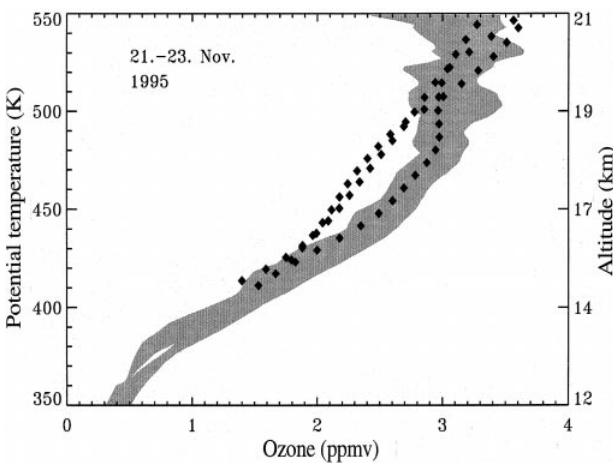
Fig. 15. The ozone profiles observed by HALOE in late November 1995 inside the vortex ( diamonds ) compared with ground-based lidar observations (at 80.0 (cid:14) N, 86.4 (cid:14) W) inside the vortex ( Donovan et al ., 1996) between November 29, and December 29, 1995. The grey area indicates the variation of the lidar profiles by (cid:6) one standard deviation around the mean profile